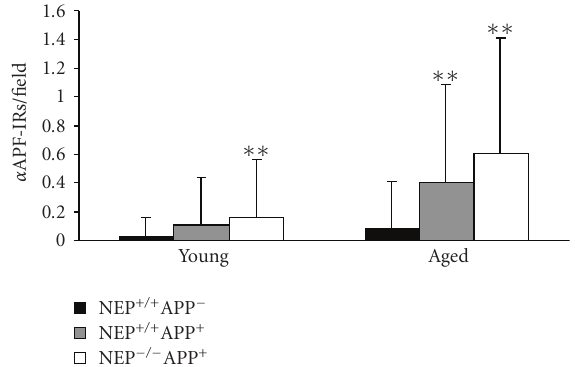
Figure 4: Density of α APF-IRs at the cell processes in mouse brain tissue. In the young group, the density was significantly higher in NEP − / − APP + mice than that in NEP + / + APP − mice ( ∗∗ , P < . 01, Sche ff e’s multiple test). In the aged group, the densities were significantly higher in NEP − / − APP + and NEP + / + APP + mice than that in NEP + / + APP − mice ( ∗∗ , P < . 01, Sche ff e’s multiple